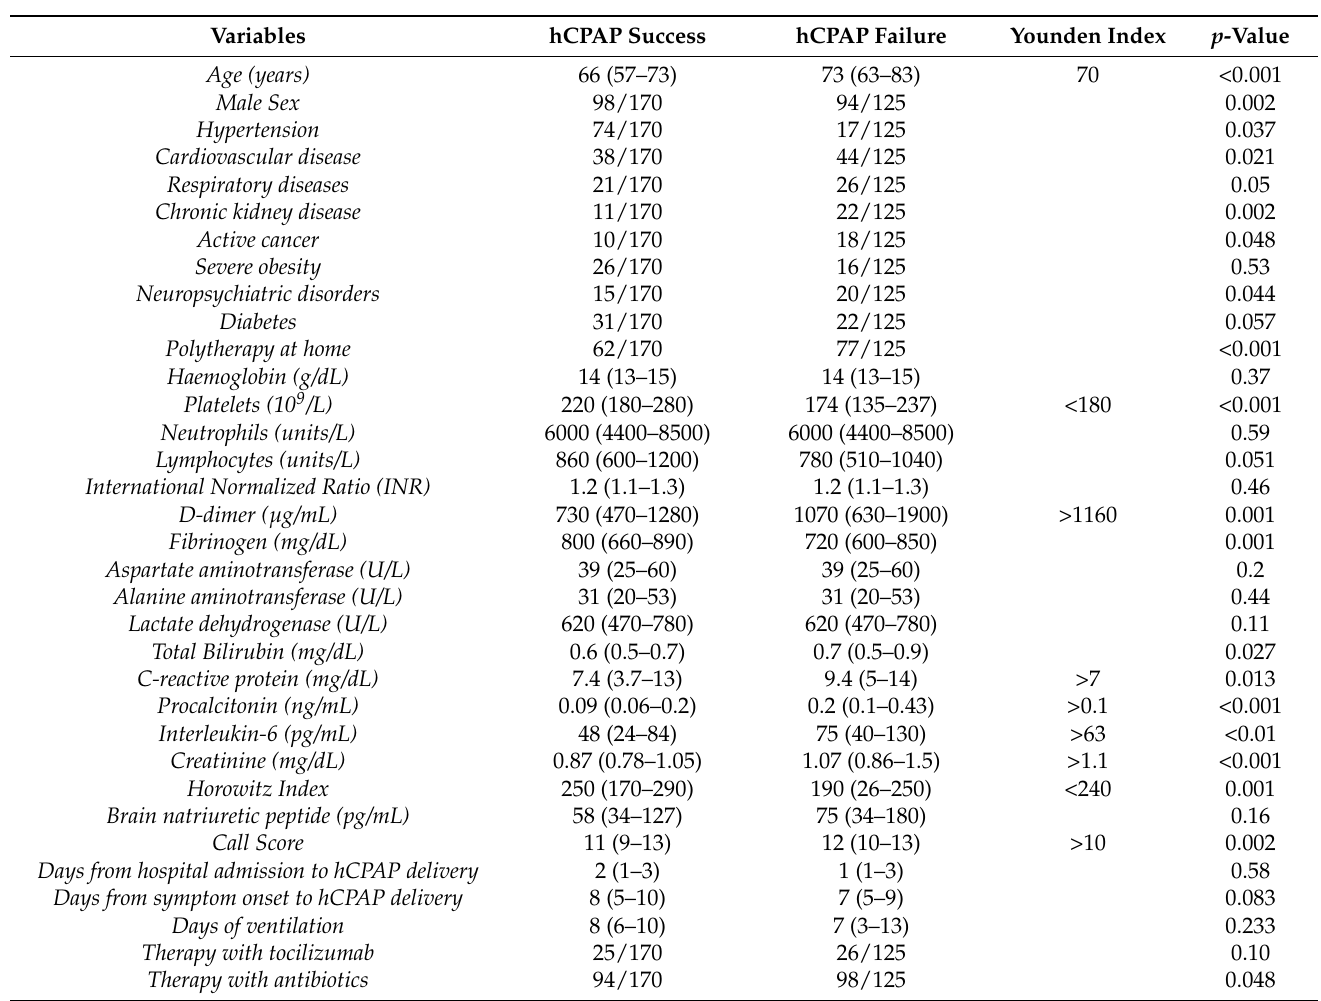
Table 3. Differences between patients with the success and failure of hCPAP. Younden indexes for hCPAP failure are also